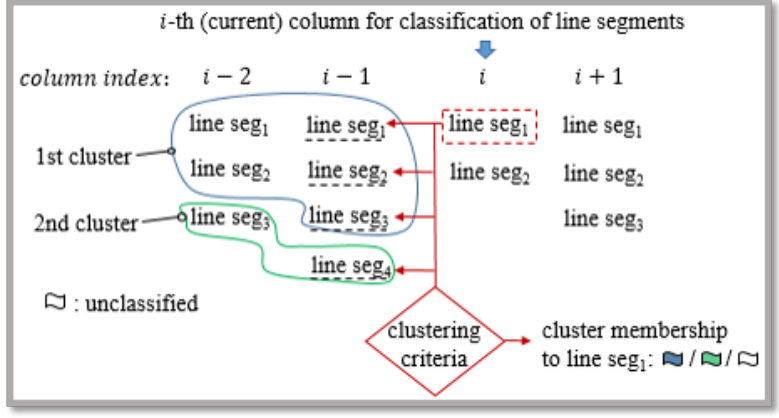
Figure 17. Flat surface clustering using line segments.